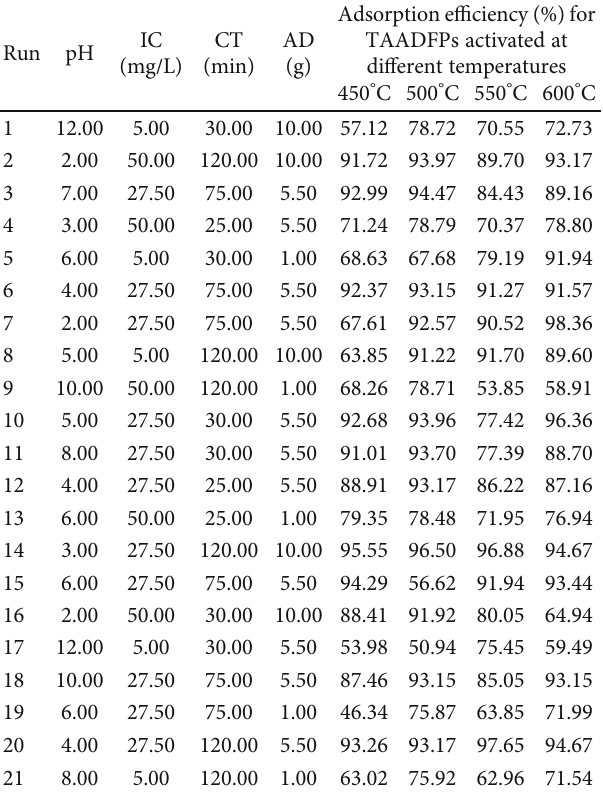
Table 1: Di ff erent experiments suggested by Design-Expert software for the optimization of conditions of pH, initial concentration (IC), contact time (CT), and adsorbent dose (AD) for de fl uoridation using